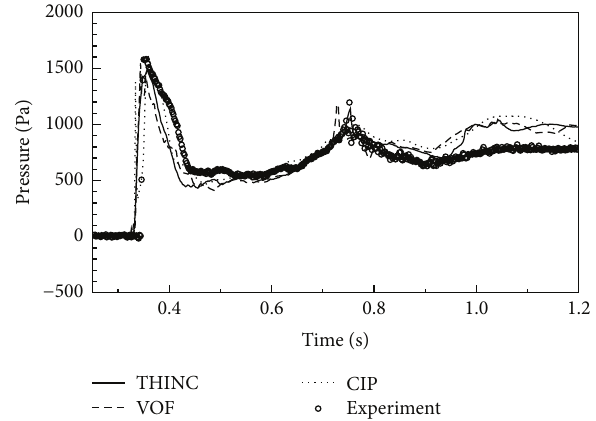
Figure 4: Impact pressure caused by 2D dam-break